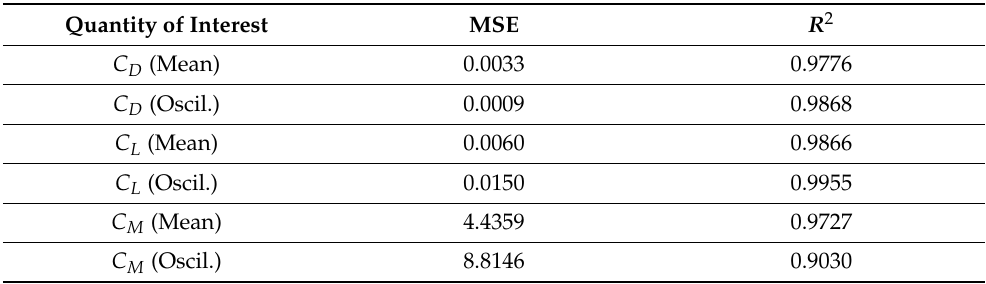
Table 3. Error estimations of the observed and predicted hydrodynamic pressure coefficients in the case of Re = 11,850.